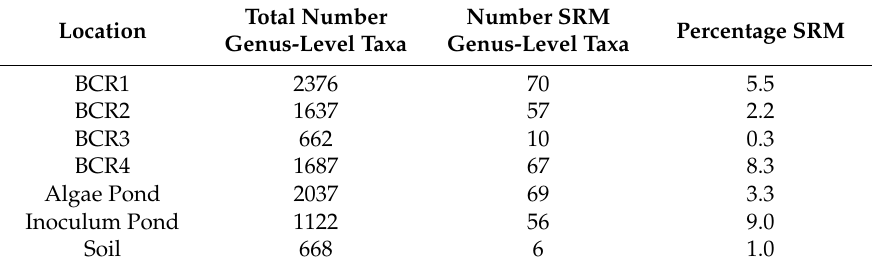
Table 2. Total number of genus-level taxonomic groups, the number of these assigned to putative SRMs and the percentage of putative SRMs in the total